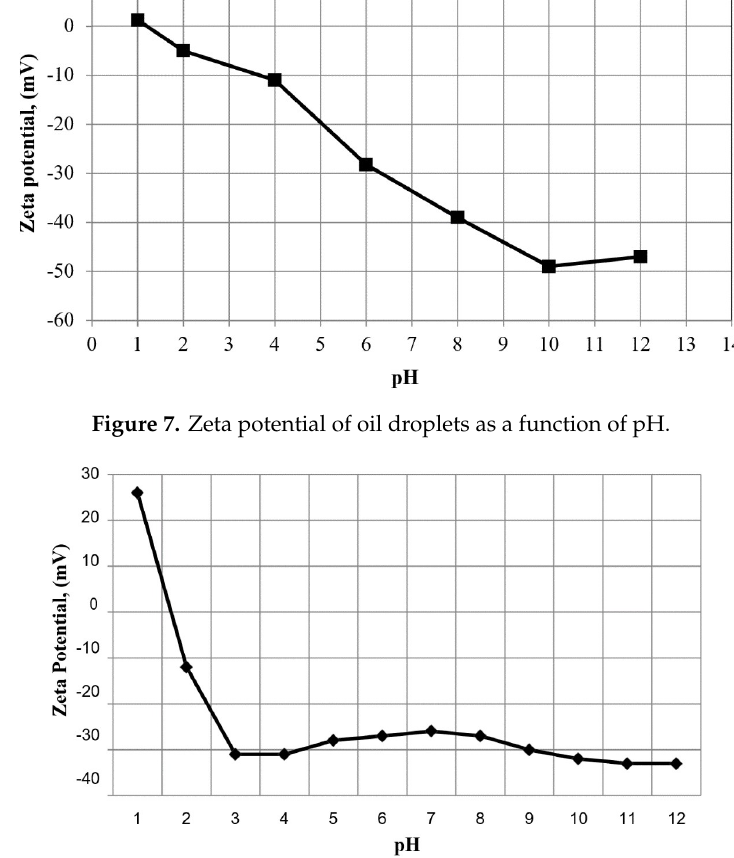
Figure 8. Zeta potential of fine bentonite clay as a function of pH.